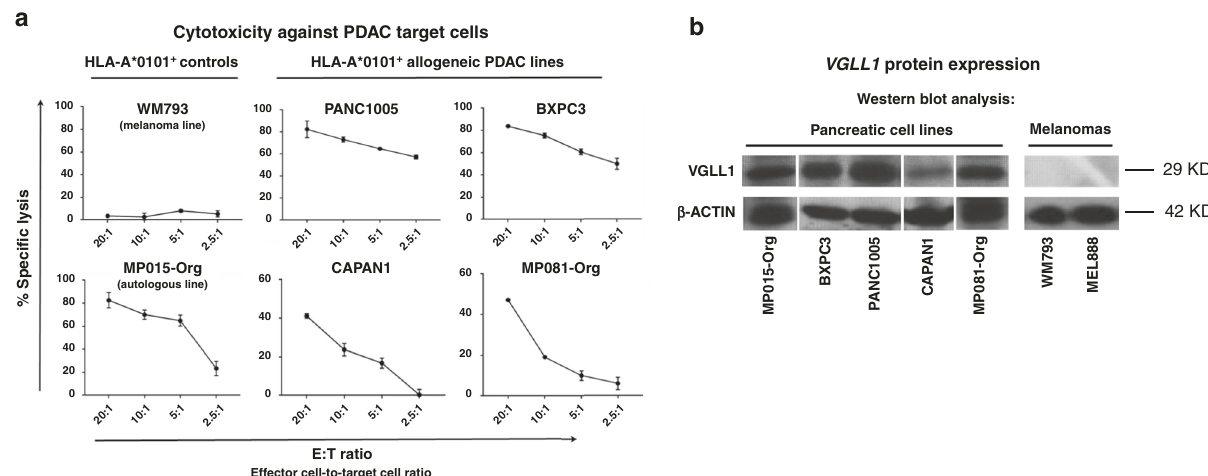
Fig. 5 VGLL1-speci fi c CTLs recognize and kill multiple allogeneic pancreatic cancer cell lines. a Expanded VGLL1-speci fi c CD8 + T cells from patient MP015 were co-cultured with a panel of HLA-A*0101-positive PDAC tumor cell lines in a standard 51 Cr release assay to measure cytotoxic activity at different effector-to-target (E:T) cell ratios. WM793 melanoma cells (VGLL1-negative, HLA-A*0101-positive) were used as a negative control line. VGLL1 CTLs robustly killed the autologous organoid cell line MP015 from which the VGLL1 peptide was originally isolated, and also demonstrated cytotoxic activity against four allogeneic, HLA-A*0101-expressing PDAC cell lines. Results show the means and standard deviations of six replicate samples, and data is representative of 4 independent experiments. b Western blot analysis showing expression of VGLL1 protein in all fi ve PDAC cell lines tested was repeated three times with similar